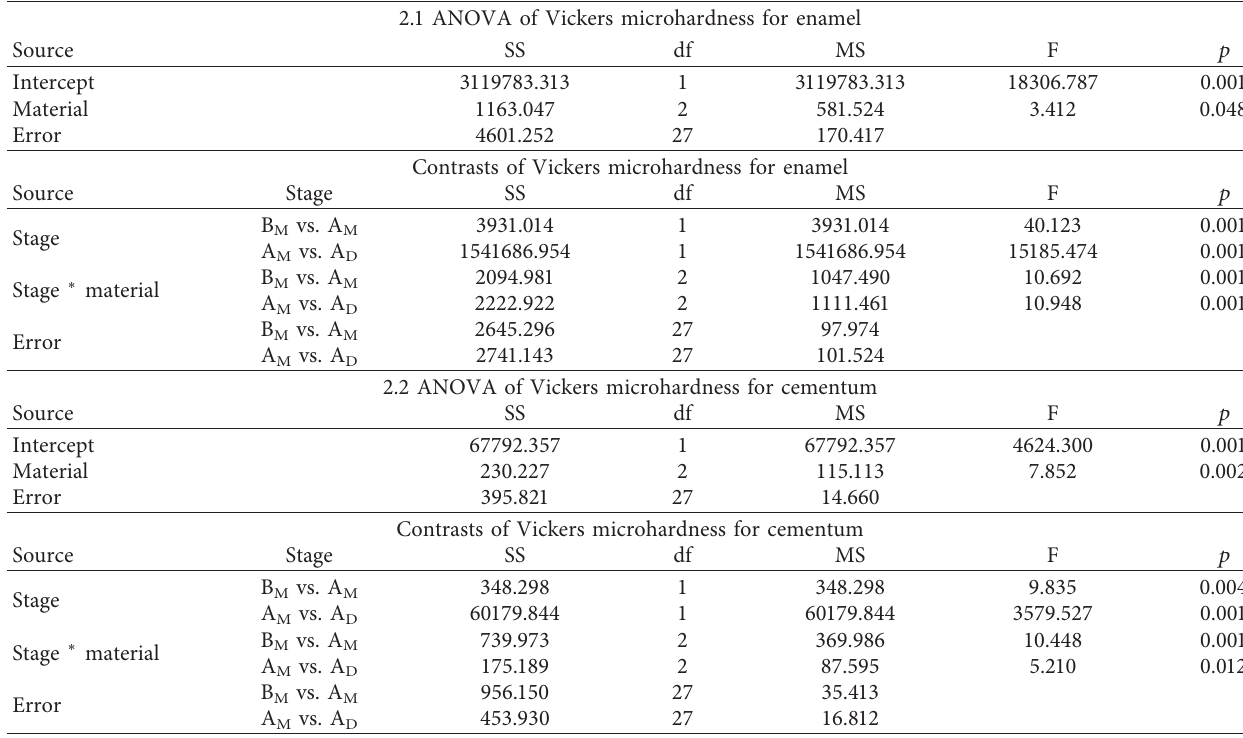
Table 2: Analysis of variance (ANOVA) and contrast of difference of Vickers microhardness upon different anti-demineralizing materials at a different stage of application for enamel (2.1) and cementum (2.2) before material application ( B M ), after material application ( A M ), and after inducing demineralization ( A D ).